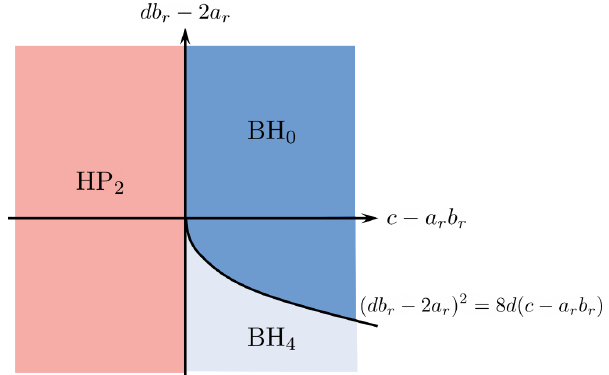
Figure 10 . We find three different possibilities for the massive vacua, depending on the values of db 2 a and c − a . The subscripts 0 , 2 , 4 label how many massive vacua there are in each r − r r b r case. The analysis is not reliable when we are very close to the vertical axis in the plot, where | P | becomes